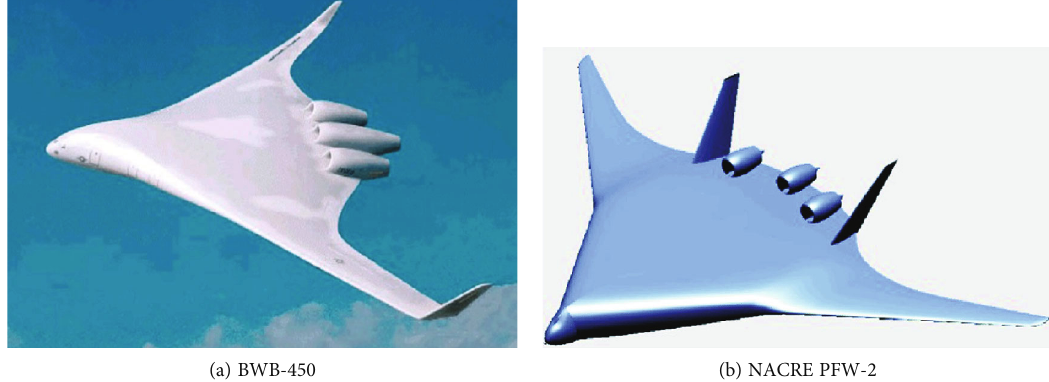
Figure 1: BWB-450 and NACRE PFW-2 con fi gurations [7].